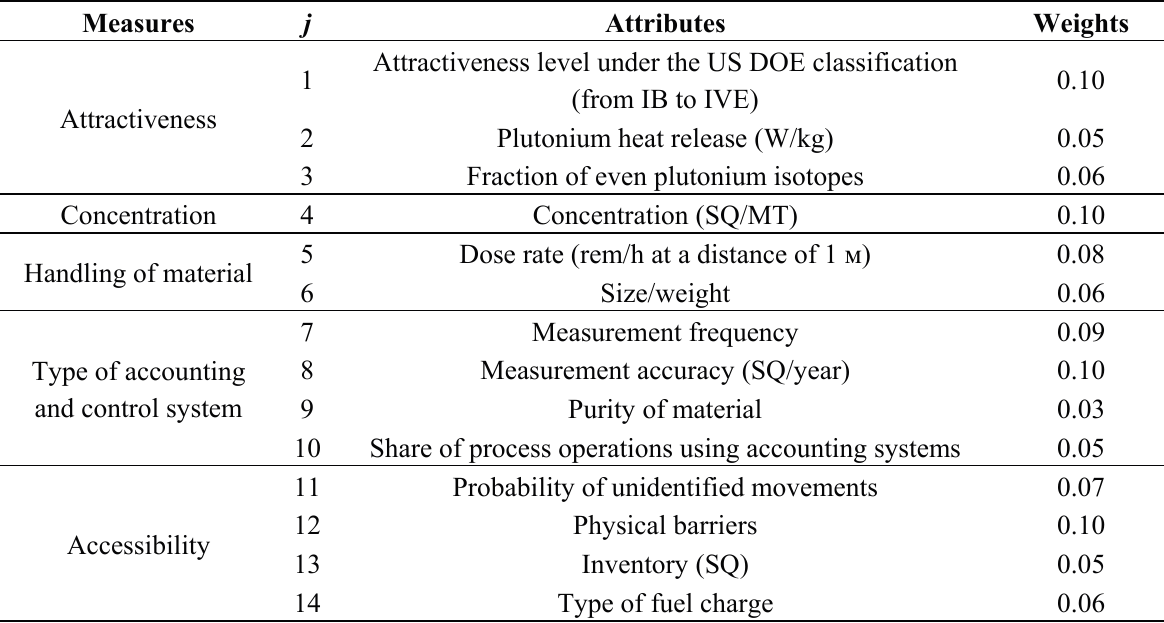
Table 5. Measures, attributes and weighing